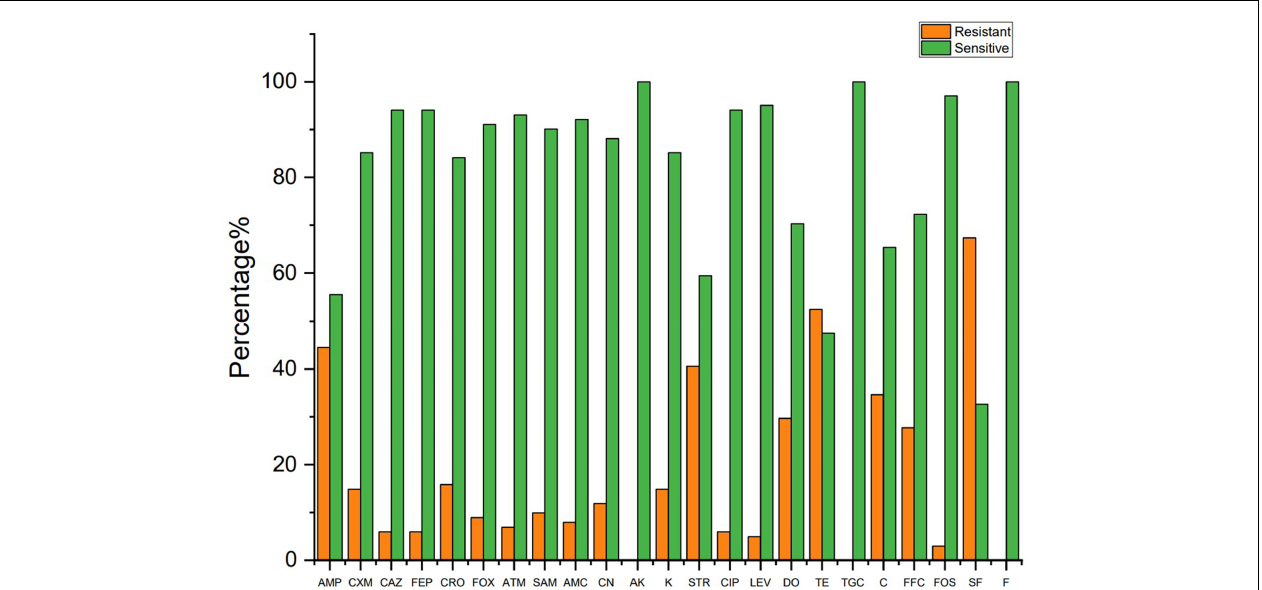
FIGURE 2 | The resistant rate of colistin resistance E. coli to other antibiotics. AMP, ampicillin; CXM, cefuroxime; CAZ, ceftazidime; FEP, cefepime; CRO, ceftriaxone; FOX, cefoxitin; ATM, aztreonam; SAM, ampicillin-sulbactam; AMC, amoxicillin–clavulanic acid; CN, gentamicin; AK, amikacin; K, kanamycin; STR, streptomycin; CIP, ciprofloxacin; LEV, levofloxacin; TE, tetracycline; DO, doxycycline; TGC, tigecycline; C, chloramphenicol; FFC, florfenicol; FOS, fosfomycin; SF, sulfisoxazole; F, nitrofurantoin.